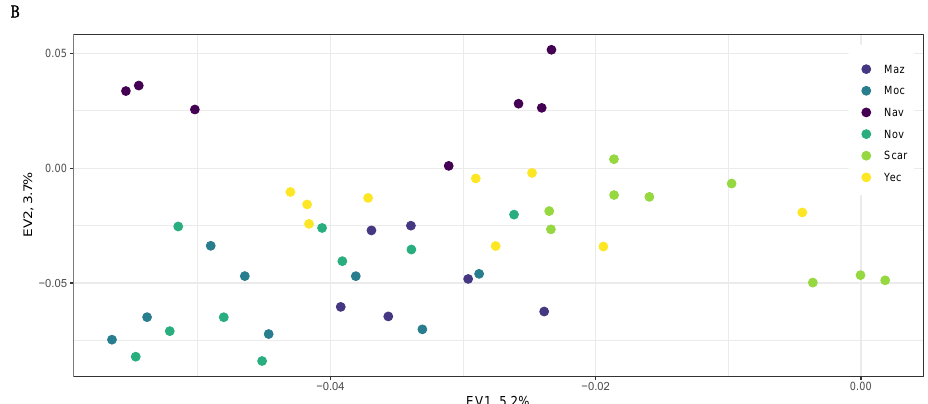
Figure 2. Relationships among ( A ) A. angustifolia var. pacifica from the state of Sonora, Mexico, wild (yellow) and cultivated (purple) samples as represented by principal component analysis (PCA) using 11,619 genome-wide SNPs and excluding 6 outlier samples. Panel ( B ) PCA representing relationships among wild samples of A. angustifolia var. pacifica . Colors corresponds to the major geographic regions detailed in Table S1.